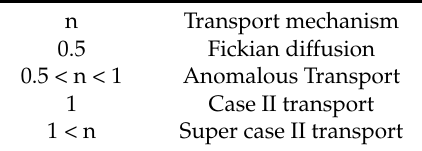
Table 1. Interpretation of drug transport mechanism for film ‐ like materials.